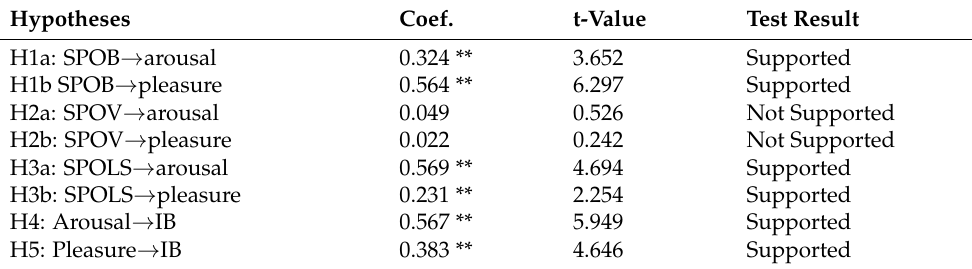
Table 5. Result summary of path analysis.